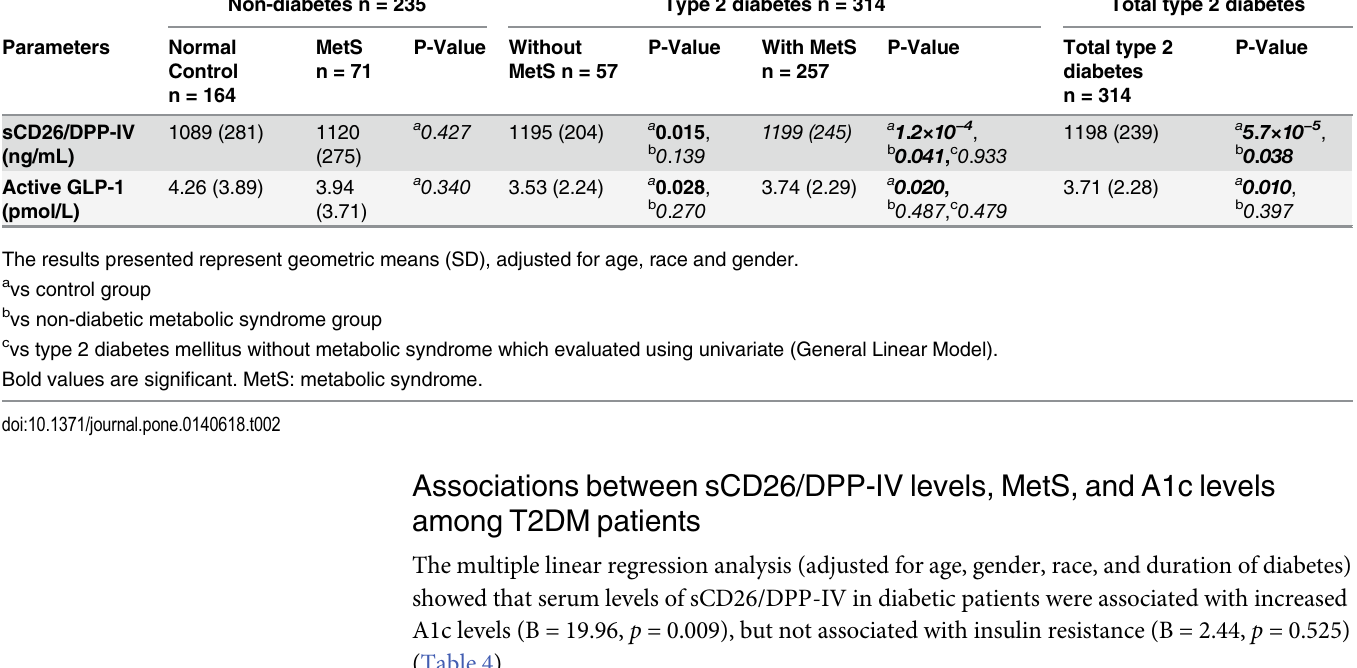
The associations between serum levels of sCD26/DPP-IV, MetS, and T2DM parameters in the control group were investigated by hierarchical linear regression after adjusting for age, race,